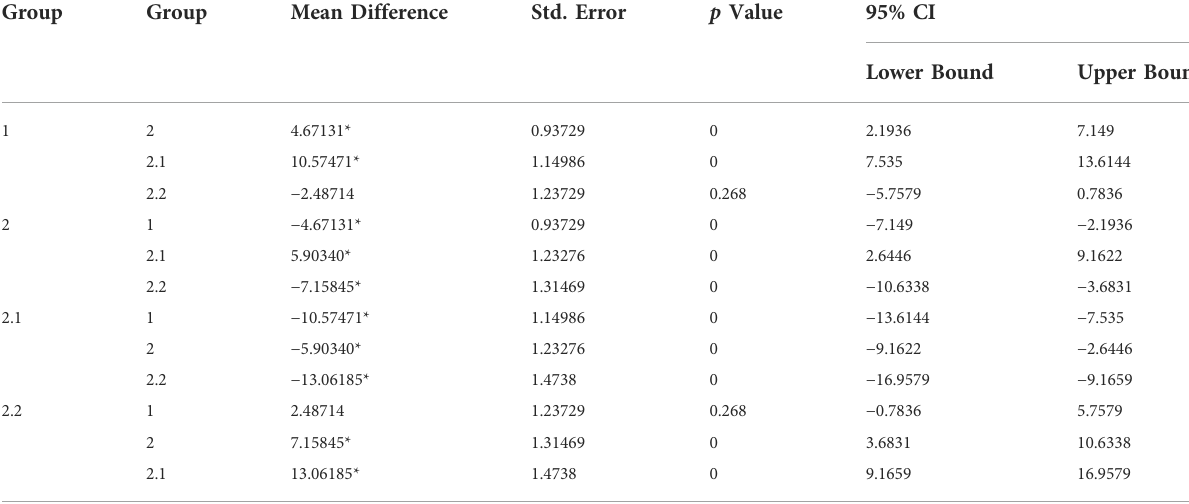
TABLE 4 Comparison of SUVmax between groups of bone lesions.